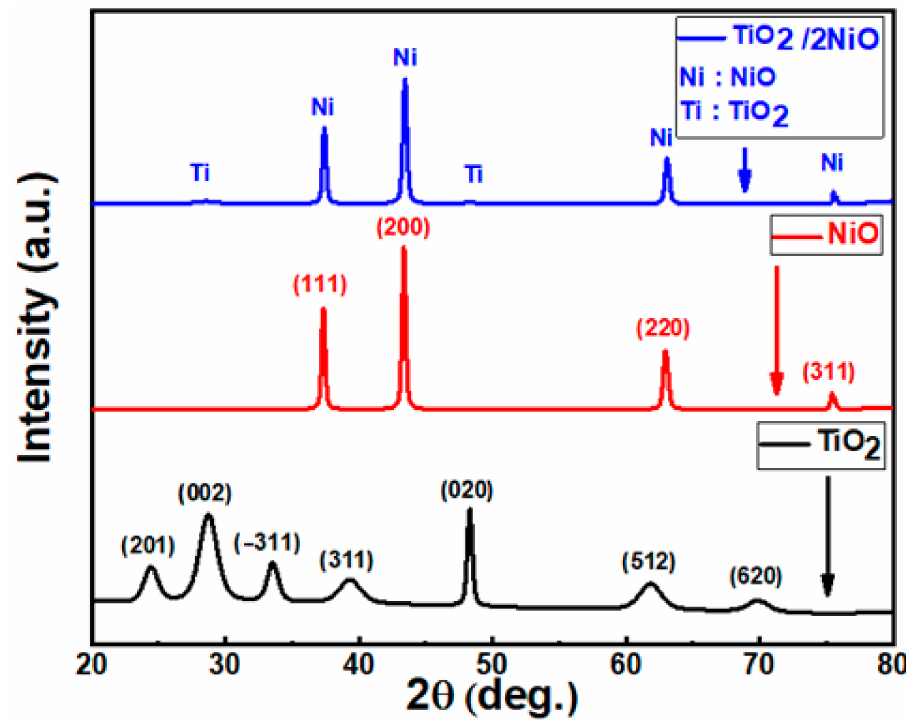
Figure 1. XRD charts of the fabricated TiO 2 NTs, NiO NPs, and TiO 2